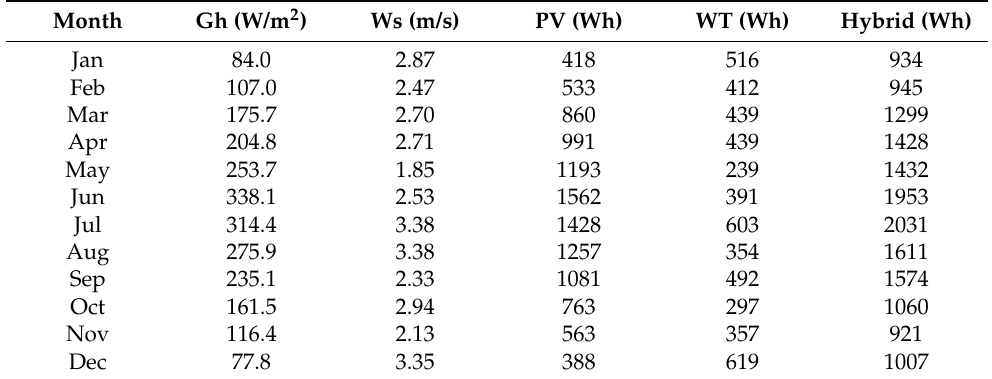
Table 4. Average monthly solar and wind resource for energy production of the optimal system 1. Month